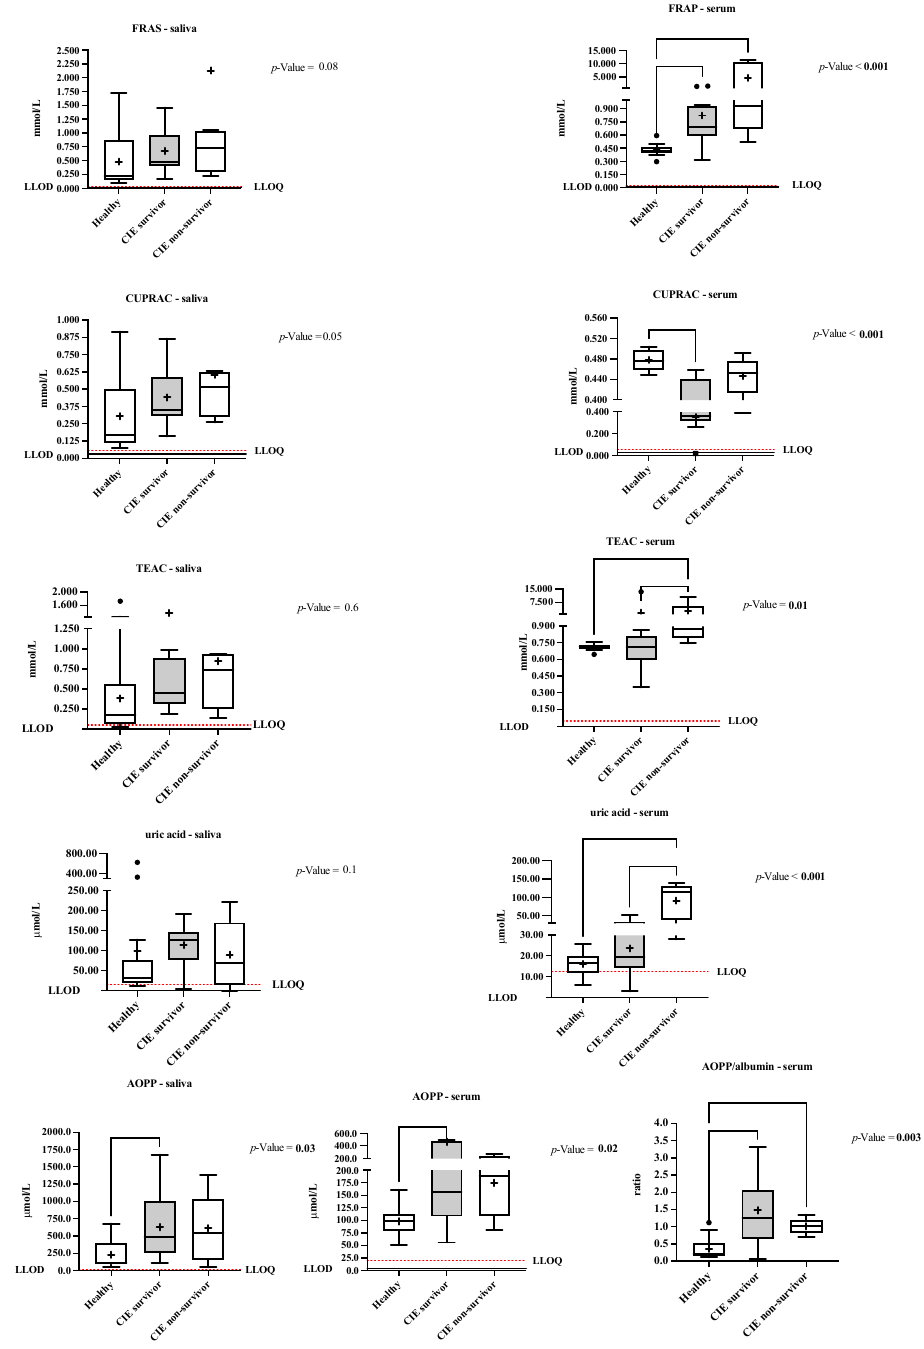
Figure 2. The ferric reducing ability of saliva/serum (FRAS/FRAP), cupric reducing antioxidant capacity (CUPRAC), Trolox equivalent antioxidant capacity (TEAC), uric acid, and advanced oxi- dation protein products (AOPP) and ratio AOPP/albumin results in healthy horses ( n = 14, dark grey), and horses which survived to the CIE ( n = 14, silver grey) vs. those that did not (non-survivors, n = 8, white). The plot shows the median (line within box), mean (the cross inside the box), 25th–75th percentiles (box), 5th and 95th percentiles (whiskers), and outliers (•). The dotted and continuous lines show the lower limit of detection (LLOD) and the lower limit of quantification (LLOQ).